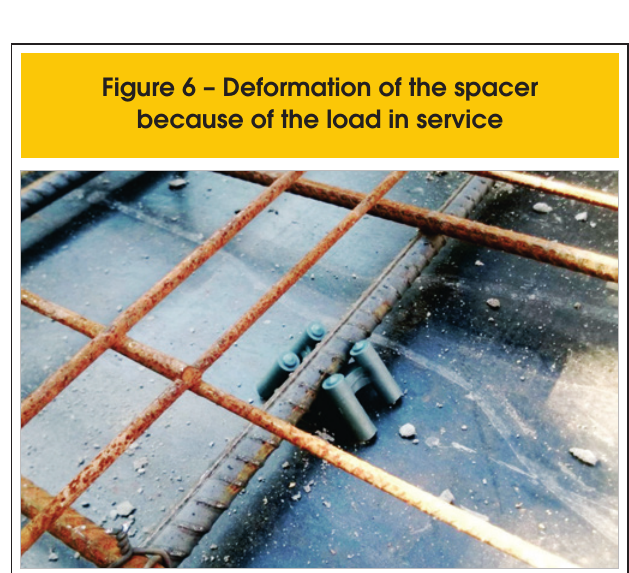
Figure 5 – Spacer that tumbled during a concreting operation